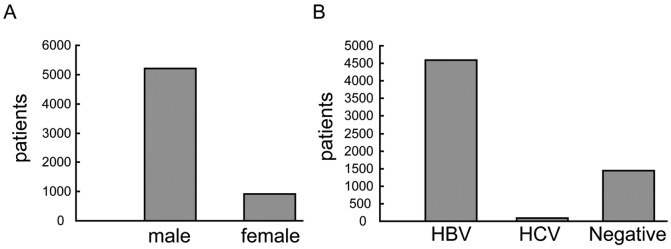
Characteristics of the HCC patients.A total of 6121 patients were diagnosed with HCC in our hospital during the past four years. A: The male to female ratio for this cohort (5203 males and 918 females). B: The majority of the patients (4590; 74.99%) were positive for HBsAg, whereas 83 patients (1.36%) were positive for HCV in this cohort.